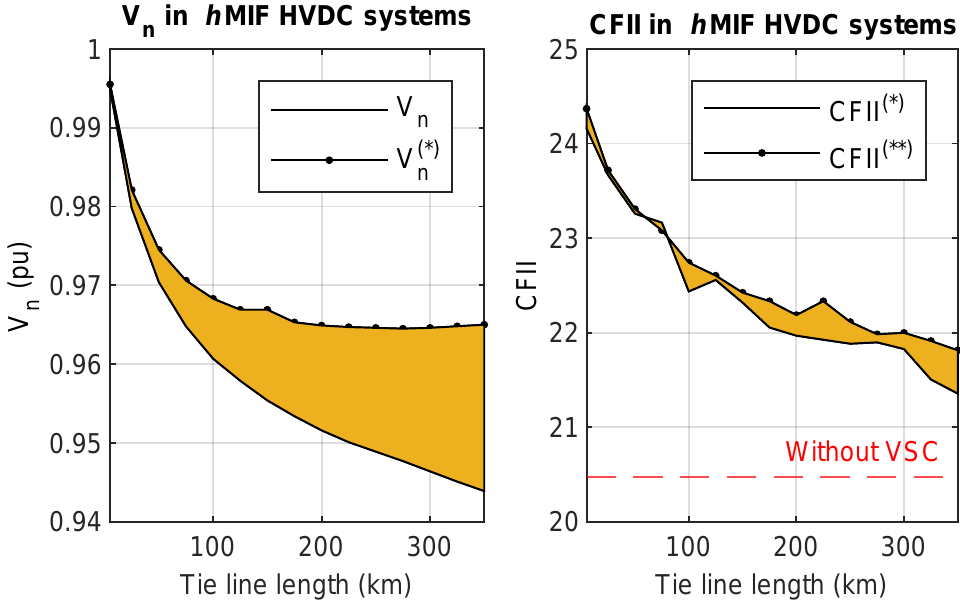
( p ) = 0 (scenario under nk